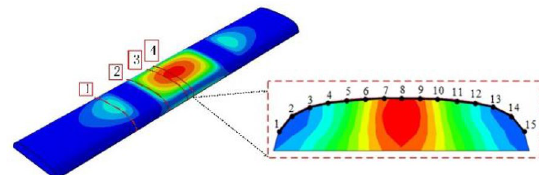
Figure 8 Schematic diagram of cross-section and node